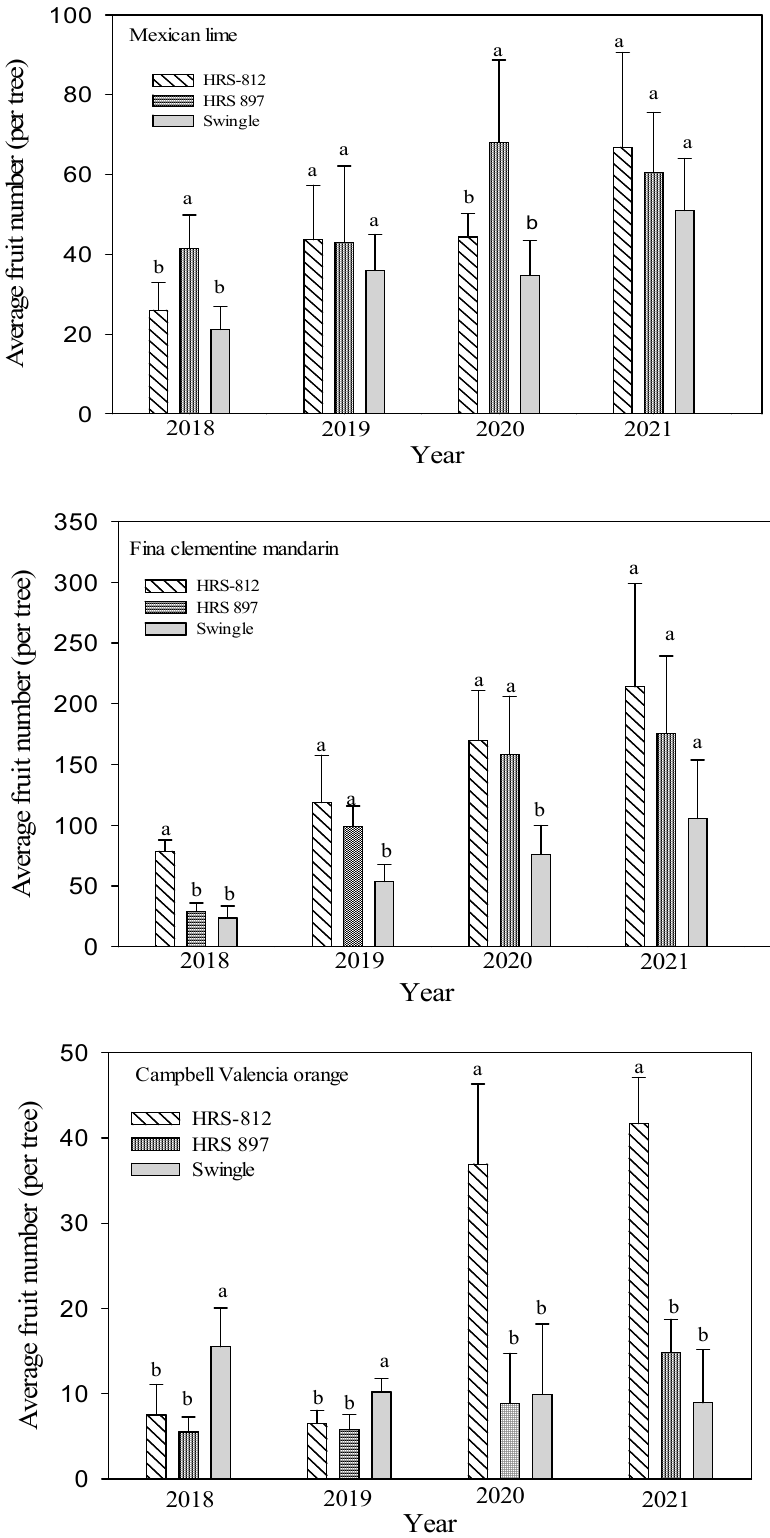
Figure 2. Total average fruit number (2018–2021) of ‘Mexican’ lime, ‘Fina’ clementine mandarin, and ‘Campbell’ Valencia orange grafted in three different rootstocks growing in Coto series soil at the Agricultural Experiment Substation of Isabela, Puerto Rico. Means ± standard error with different letters for each scion and year are not significantly different according to Tukey’s test at α < 0.05.